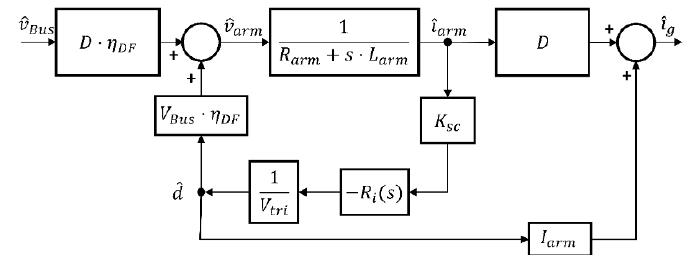
Figure 18. Block diagram of the motor drive-electric motor-vehicle system, including the inner control loop.